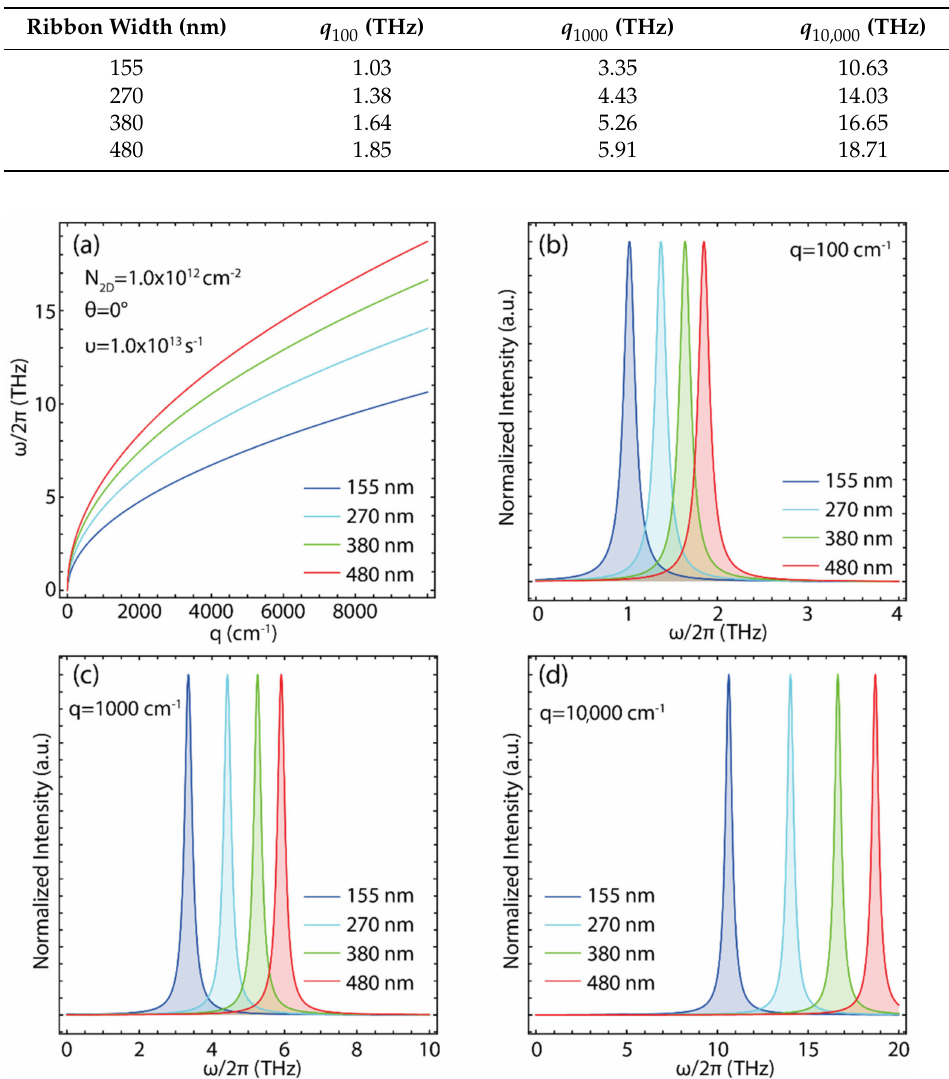
Table 2. Maximum of the plasmon peak for selected momenta ( q = 100, 1000, 10,000 cm − 1 ).